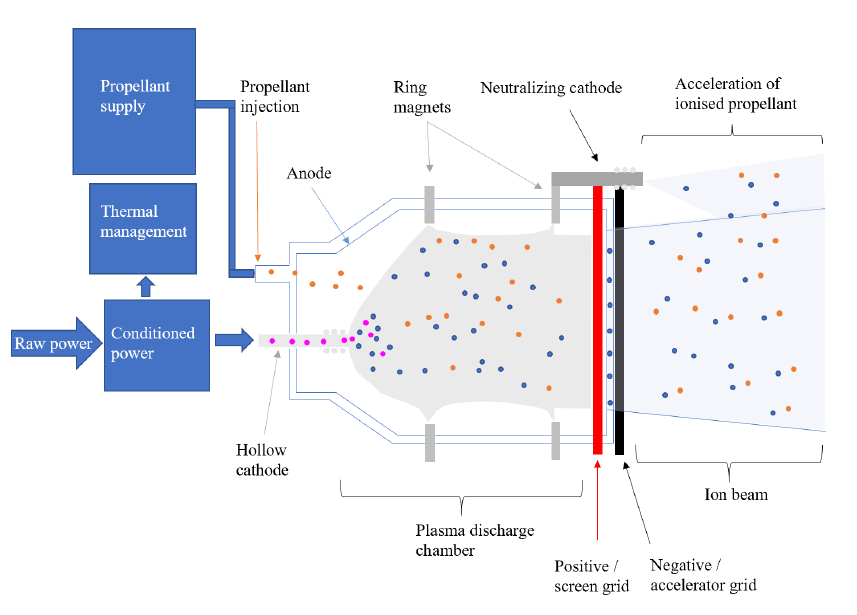
Figure 5. A two grid Gridded Ion Thruster (GIT) as a simplified schematic